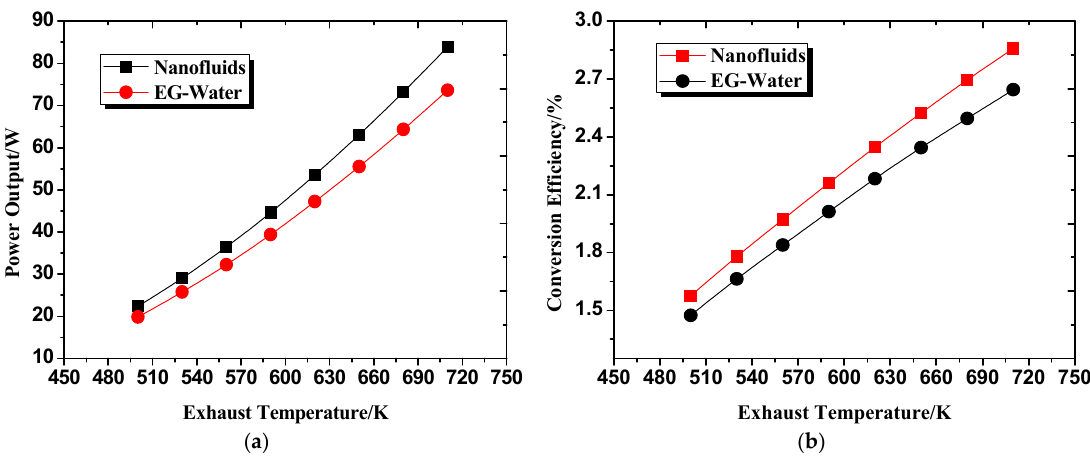
Figure 4. Variations of power output and conversion efficiency with inlet temperature of exhaust under two coolants: ( a ) Power output; ( b ) Conversion efficiency. Table 3. Computational parameters of Cu-Ethylene glycol (Cu-EG) nanofluid under different